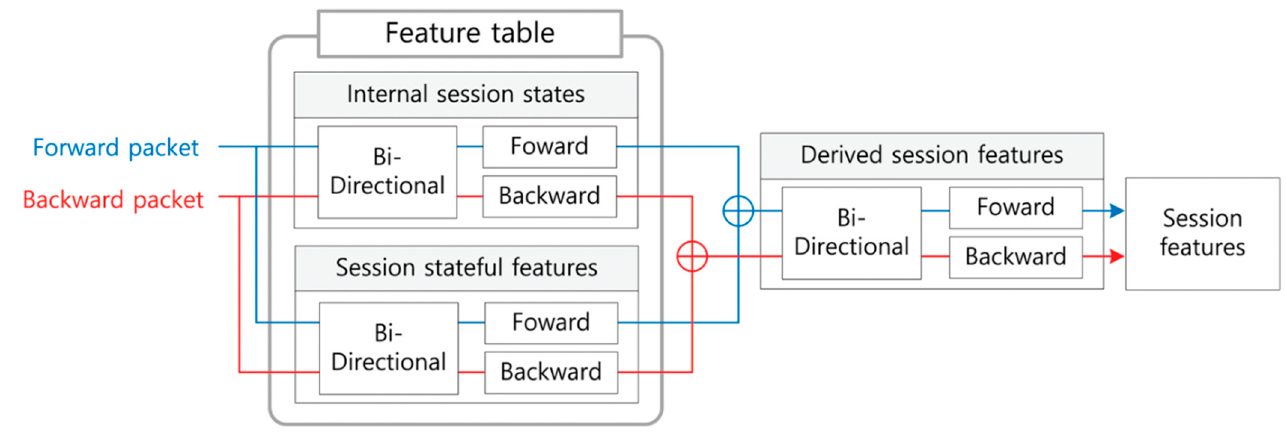
Figure 1. IFG block diagram for single-host feature creation.